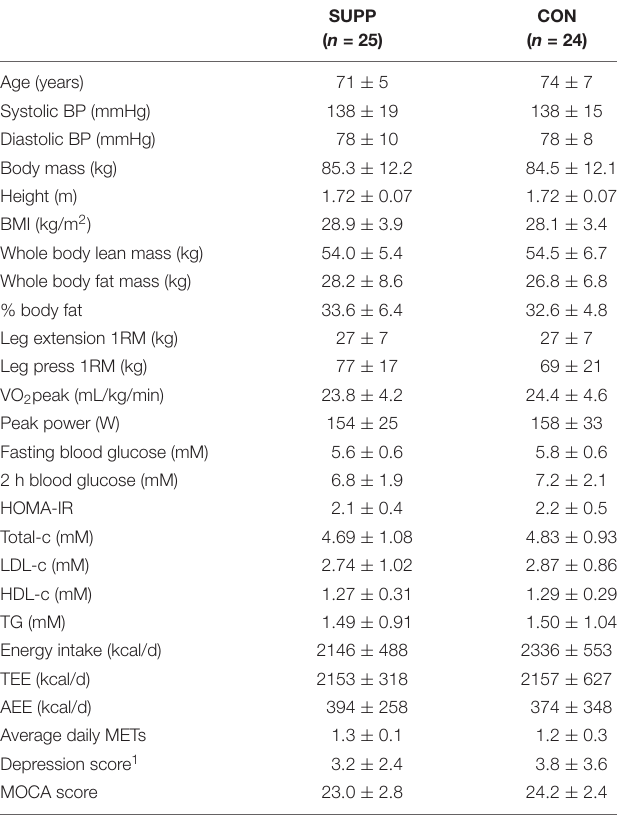
TABLE 1 | Baseline physical